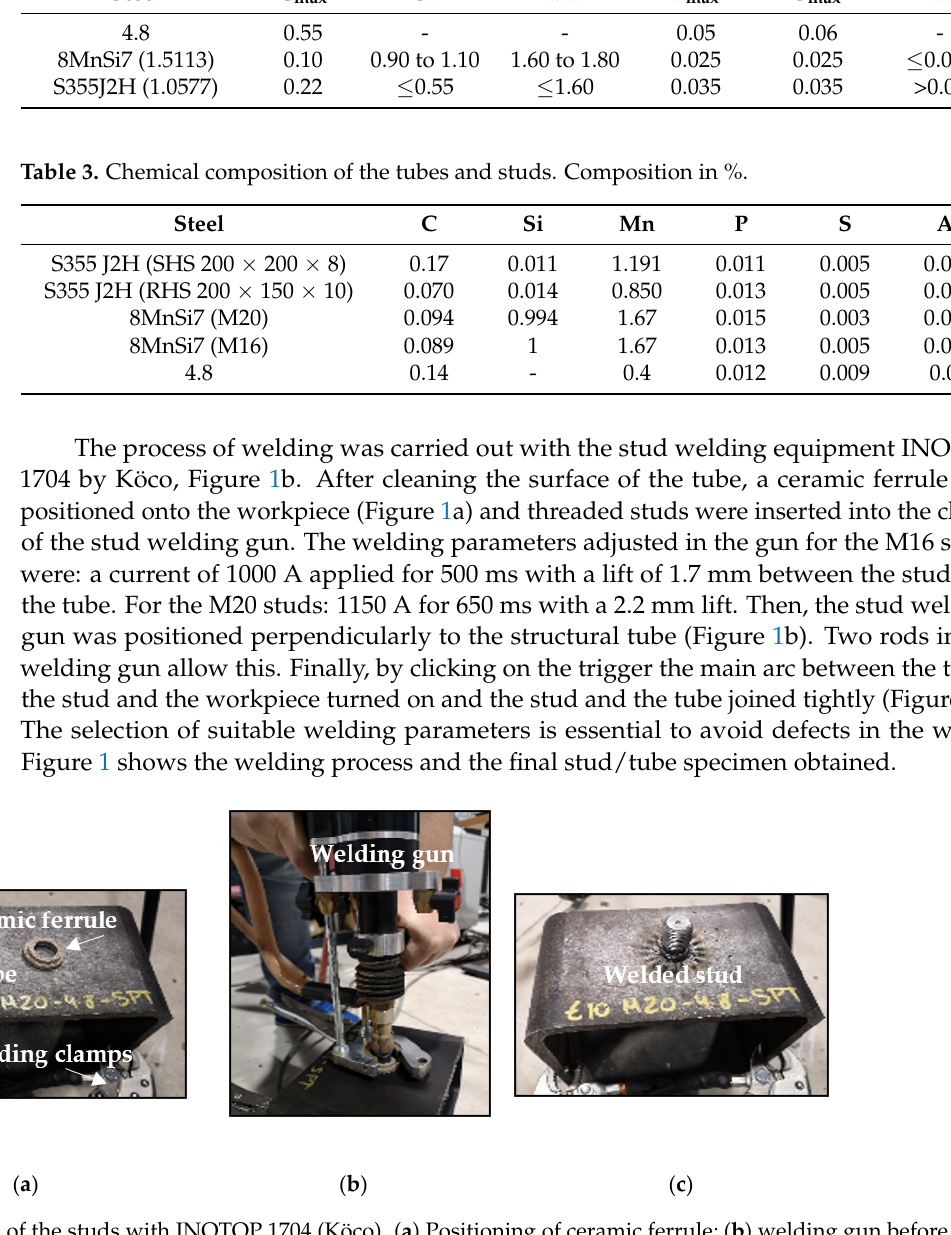
Table 2. Limitations on chemical composition (%) of the 4.8 steel grade, 8MnSi7, and S355J2H. Steel